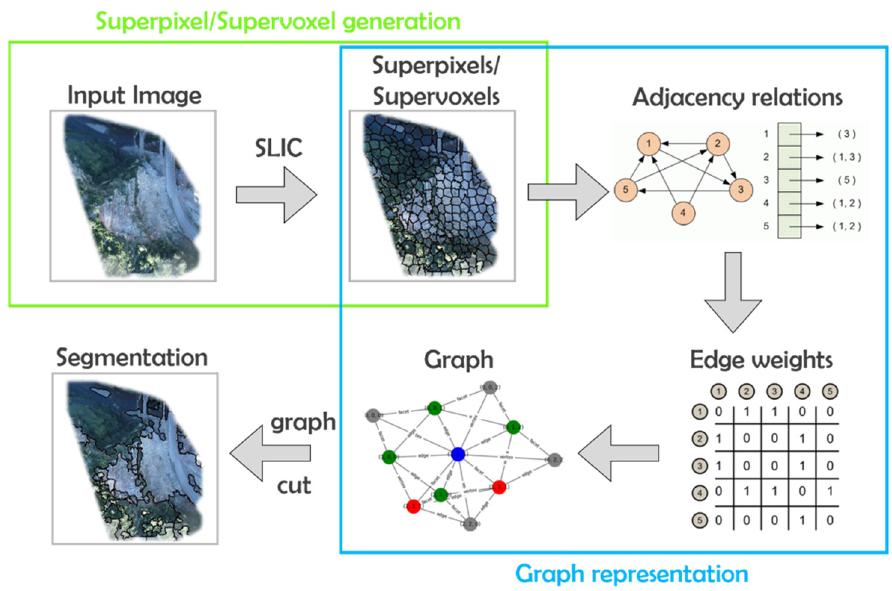
Figure 2. Step-by-step illustration of the segmentation pipeline developed for the segmentation of the multi-dimensional UAV-derived models. the multi-dimensional UAV-derived